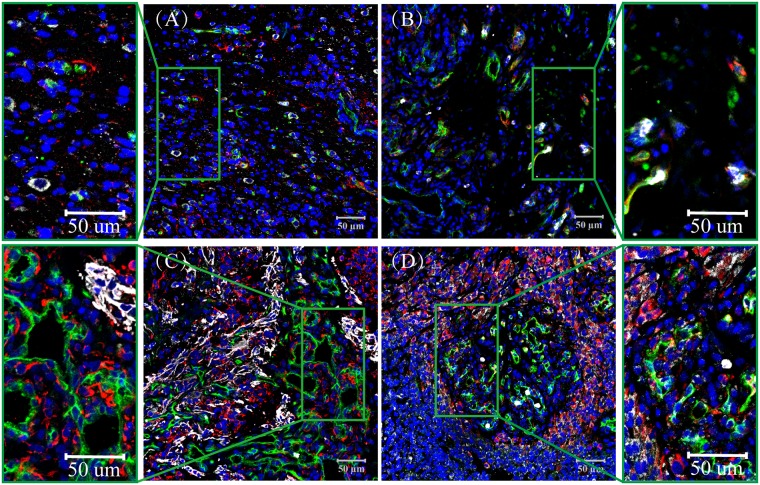
CD133/Nestin/CD34 Expression in Glioblastoma, CD133 (Purple), Nestin (Red), CD34 (Green). Nuclei are Counter stained with DAPI (Blue).(A) microvascular sprouting (MS), many Nestin and CD133 positive cells are scattered; (B) vascular cluster (VC), the Nestin and CD133 positive cells have a regional maldistribution; (C) vascular garland (VG), a mass of Nestin positive cells are accumulated as a cluster. Nestin was expressed not only on GSCs but also in the brain capillaries on endothelial cells, and CD133 positive cells accumulated around the blood vessels; (D) glomeruloid vascular proliferation (GVP), with a large number of Nestin and CD133 positive cells in the periphery of vessels and fewer in the avascular area. Nuclei are always counterstained with DAPI (Blue).